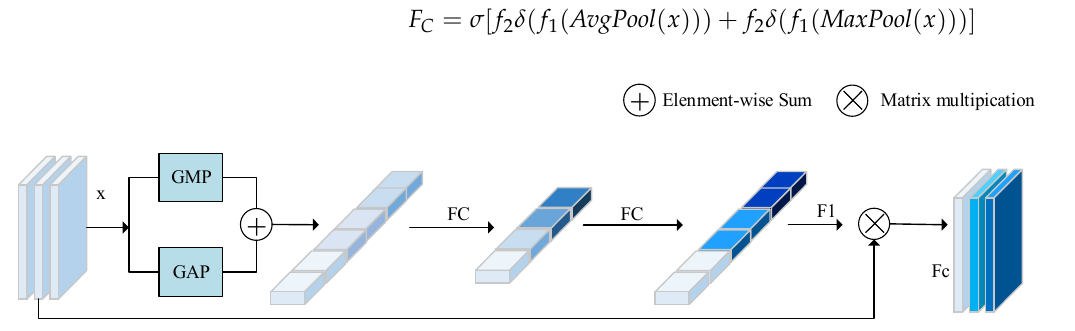
Figure 3. Channel attention block.